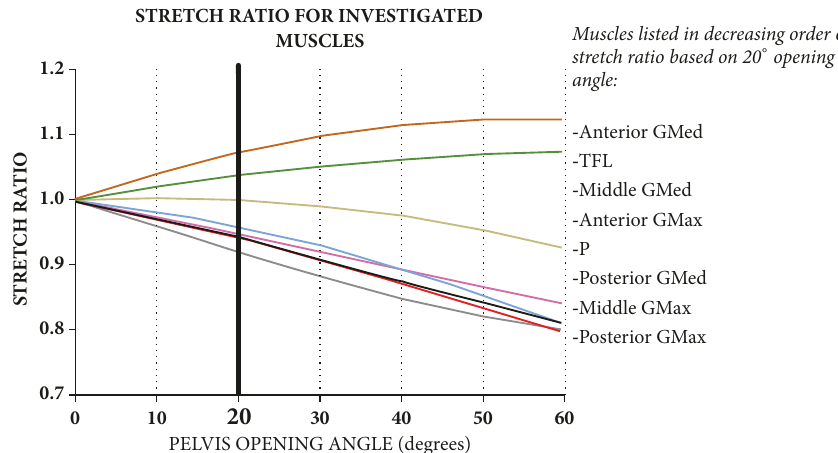
Figure 7: Graph showing the correlation of pelvis opening angle (OA) and the stretch ratio (SR) of selected muscle segments.